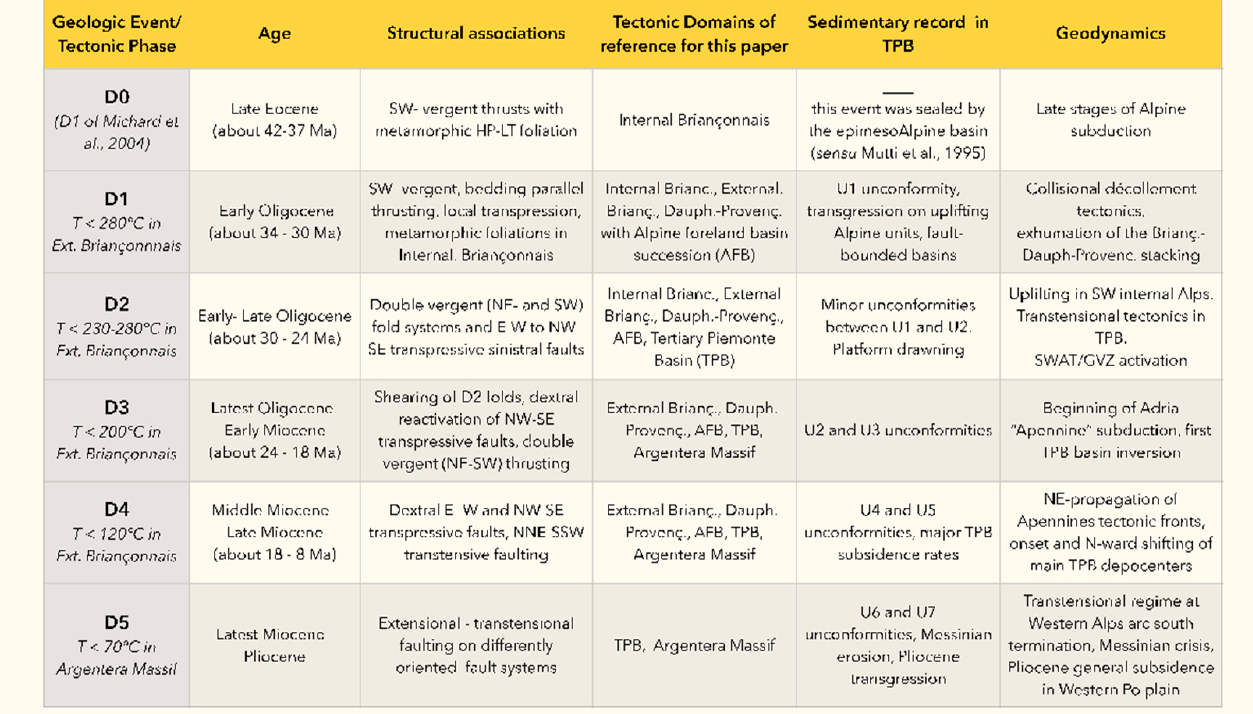
Figure 11. List of the Alpine Geologic events (D1–D5) recorded in the southern termination of Western Alps since Early Oligocene. The U1, U2…D7 unconformities correspond to the D1, D2…D7 regional unconformities of the TPB, as defined in [19,74]. The column “geodynamics” describes the relations with the main stages of the tectono-sedimentary evolution of the southern termination of the Western Alps and of north-western Apennines.